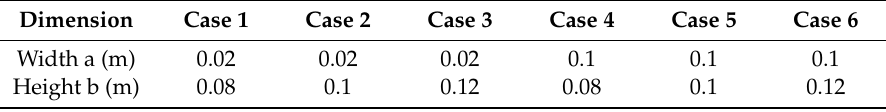
Table 2. Dimensions of six rectangular breakwaters.